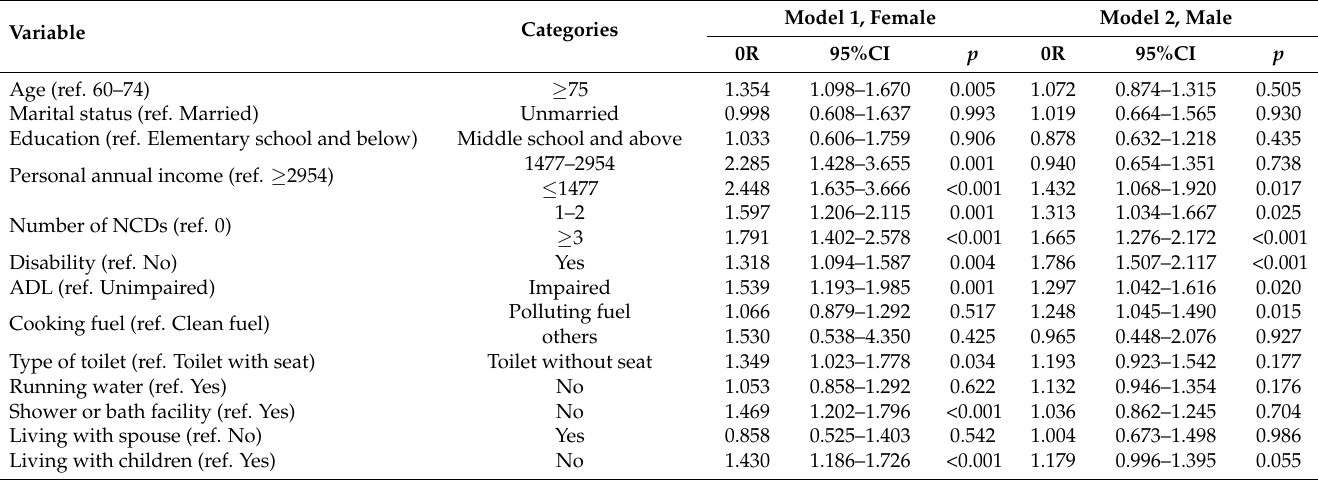
Table 3. Logistics regression of physical housing environments and living arrangements associated with depressive symptoms by